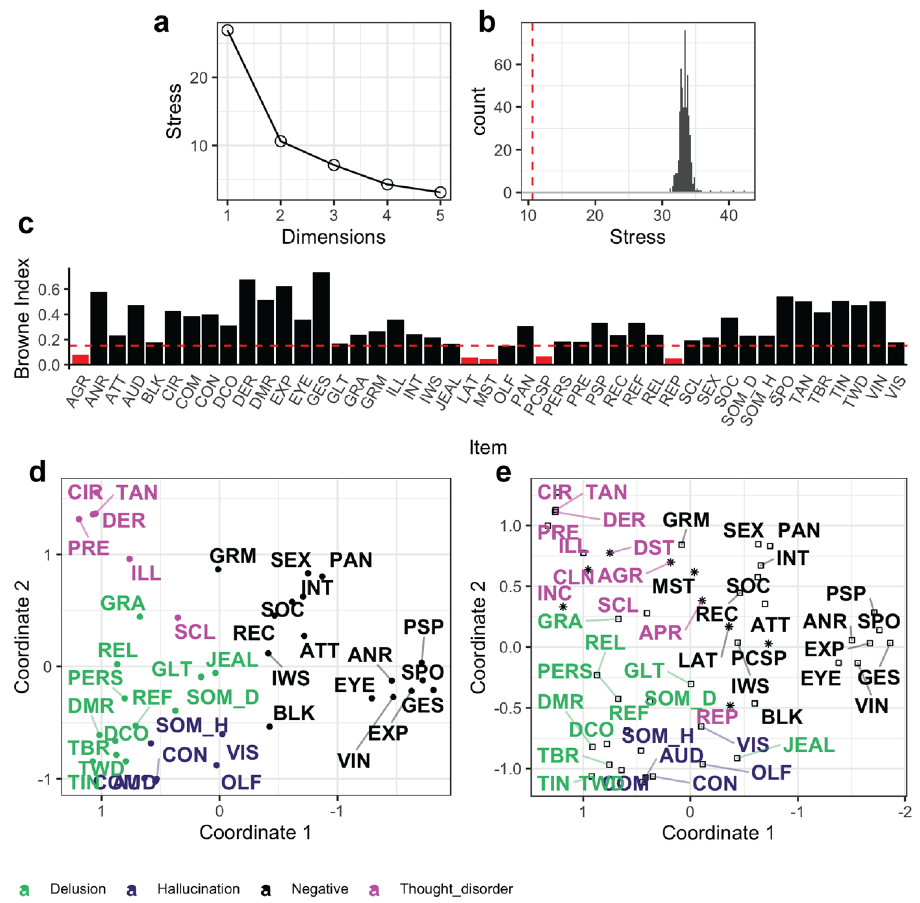
Figure 1. Multidimensional scaling solution for persistent psychotic illness sample. ( a ) Scree plot representing stress on the model across different potential numbers of dimensions used in the solution. ( b ) Permutation test results with distribution of estimated stress from 500 randomly permuted sets of our data. Stress in the experimental solution (red line) was significantly less (p < 0.001). ( c ) Communality exclusion criteria shown based on Browne index values plotted across all items of SAPS and SANS. Cutoff criteria indicated by red dashed line; those items lying below this criterion and therefore excluded filled in red (items which failed to pass inclusion criteria for endorsement not shown). ( d ) Two-dimensional solutions for our MDS analysis. The colors are added to differentiate subgroups of symptoms previously identified in the literature. ( e ) MDS solution with all items included (no exclusion criteria) with items that met inclusion criteria labeled by the box and items which were excluded from the original analysis (and therefore not included in d ) in asterisk.